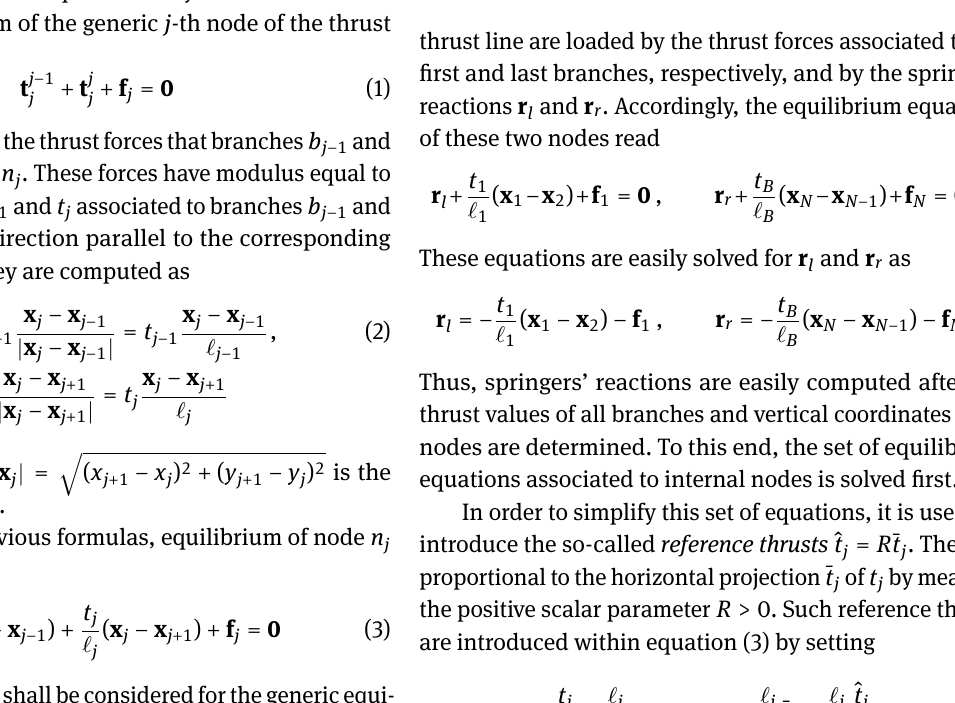
by the adjacent branches. In order to model these internal forces, a thrust value t j is associated to the generic j -th branch of the thrust line. Since it represents a compressive force, t j must be positive, i.e. t j > 0, j = 1, ..., B . Within the TLA framework, the horizontal position of nodes and the external forces are known. Thrusts asso- ciated to branches, vertical position of all nodes and the reactions of springers are unknown. In the spirit of the Heyman’s safe theorem, these unknowns are computed by employing equilibrium equations only.